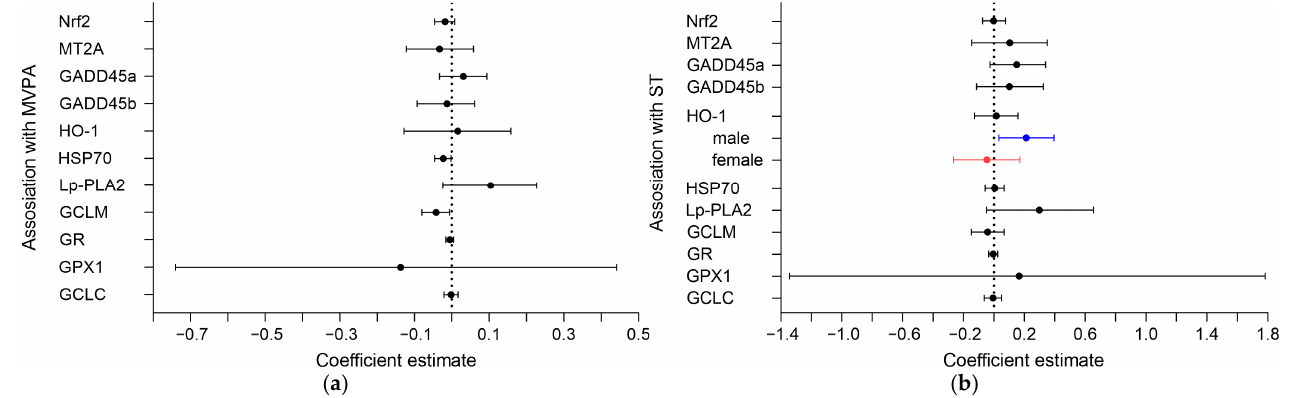
Figure 3. Regression coefficient estimations with confidence intervals showing the association between mean ( a ) MVPA (10-min units) and ( b ) mean ST (10% units) and mRNA expressions (in arbitrary units) of outcome variables. Women with higher MVPA had lower placental HSP70 and GCLM mRNA expression. Women with higher mean ST and pregnant with a male fetus (blue line) had higher placental HO-1 mRNA expression.